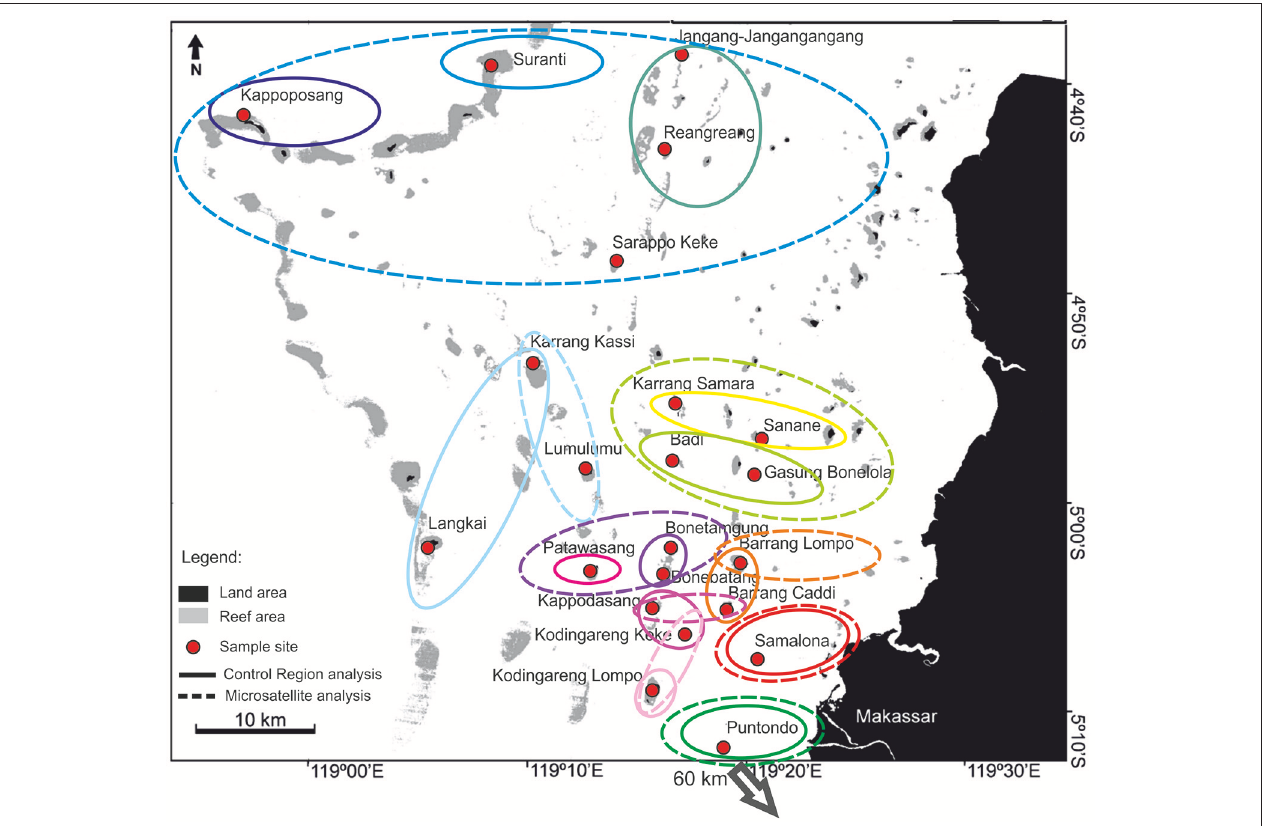
FIGURE 3 | Results of the hierarchical AMOVA (Arlequin ver.3.5, Excoffier et al., 2005) for the clown anemonefish, A. ocellaris , in Spermonde Archipelago and Puntondo. Analysis is based on 6 microsatellite loci (solid circles; 13 groups: F ct = 0.013; p = 0.01) and control region sequences (dashed circles; 9 groups: 8 ct = 0.076; p <